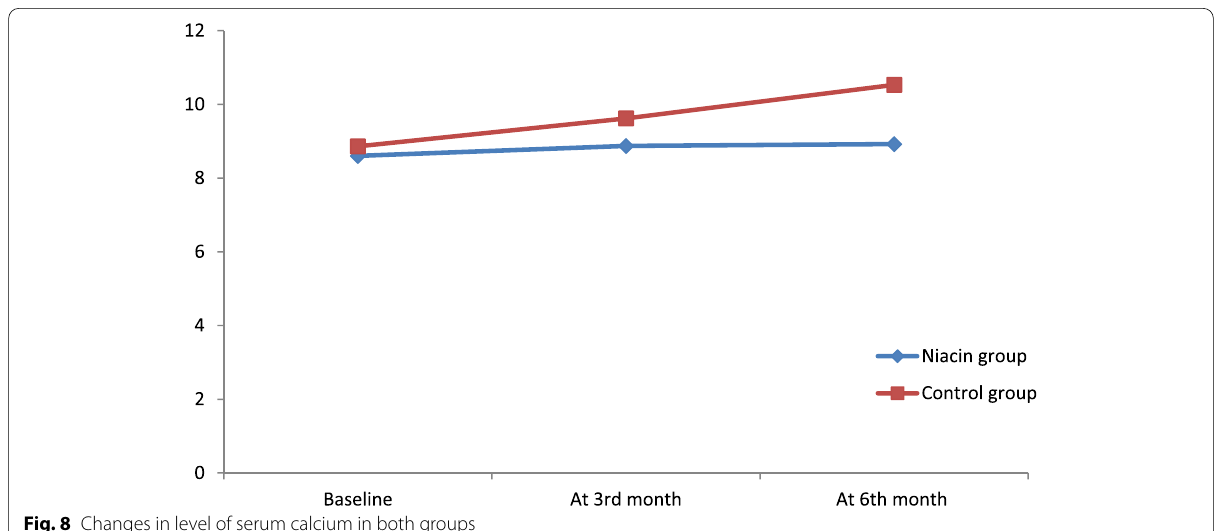
Fig. 8 Changes in level of serum calcium in both groups